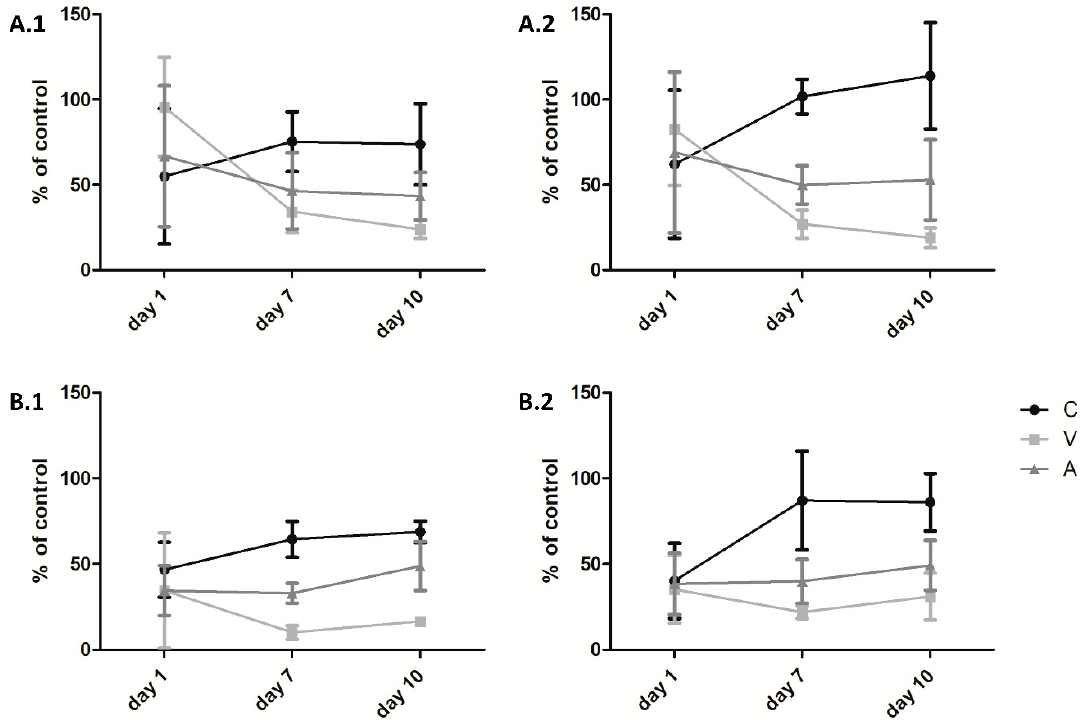
Figure 6. Proliferation of ( A ) human osteoblasts and ( B ) primary human muscle cells on (1) unmodified and (2) modified (RGX: 10 min, 0.01% RB) collagen sheets for 1, 7 and 10 days. The results are presented in percentage of the control without collagen sheet (100%). C: Collagen Solutions, V: Viscofan and A: Atelocollagen.